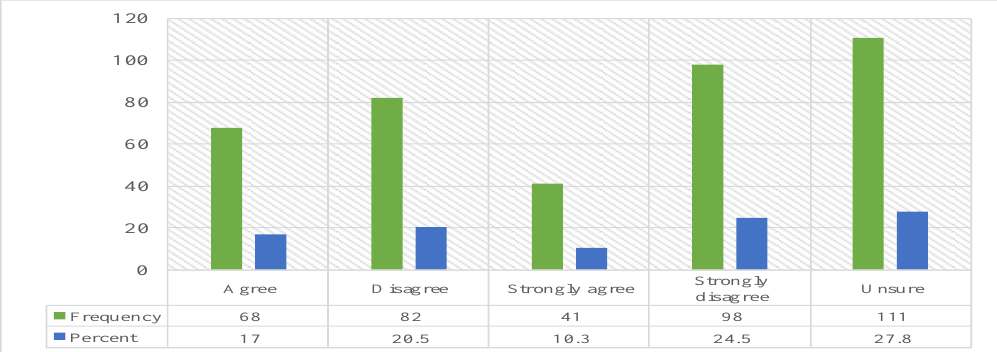
Figure 5: Feedback and inputs consideration by the municipality; Source :